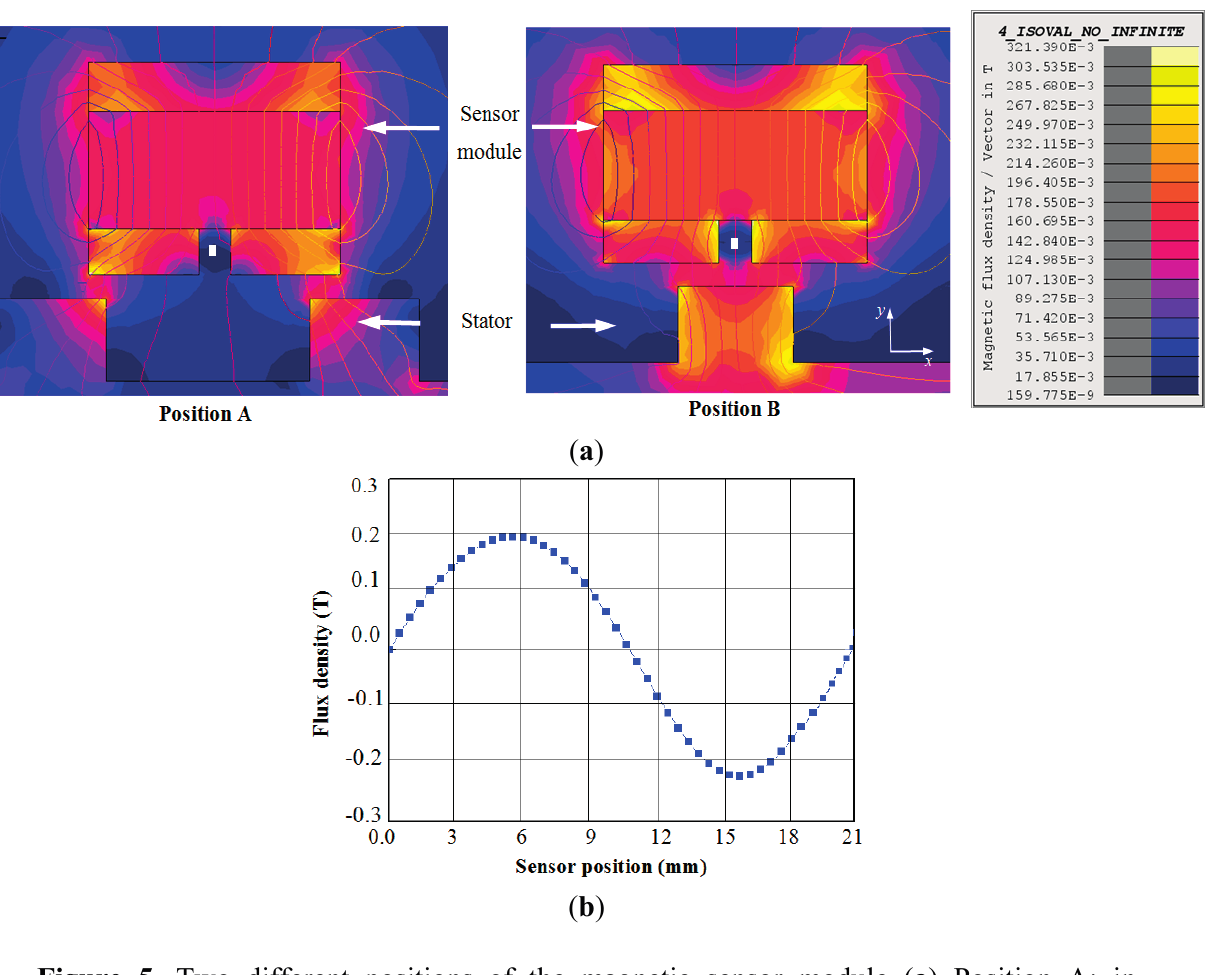
Figure 5. Two different positions of the magnetic sensor module ( a ) Position A: in between two teeth of the stator, Position B: aligned with the stator tooth and the flux flow path at A and B positions respectively; ( b ) change in flux density according to the position of the magnetic sensor